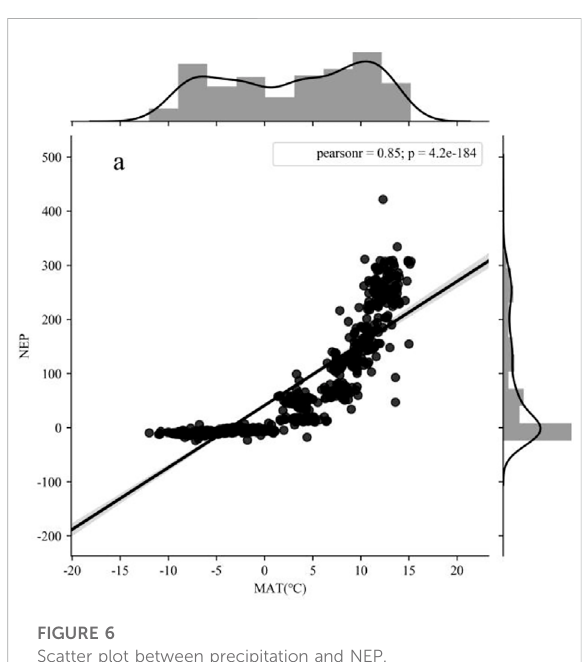
FIGURE 6 Scatter plot between precipitation and